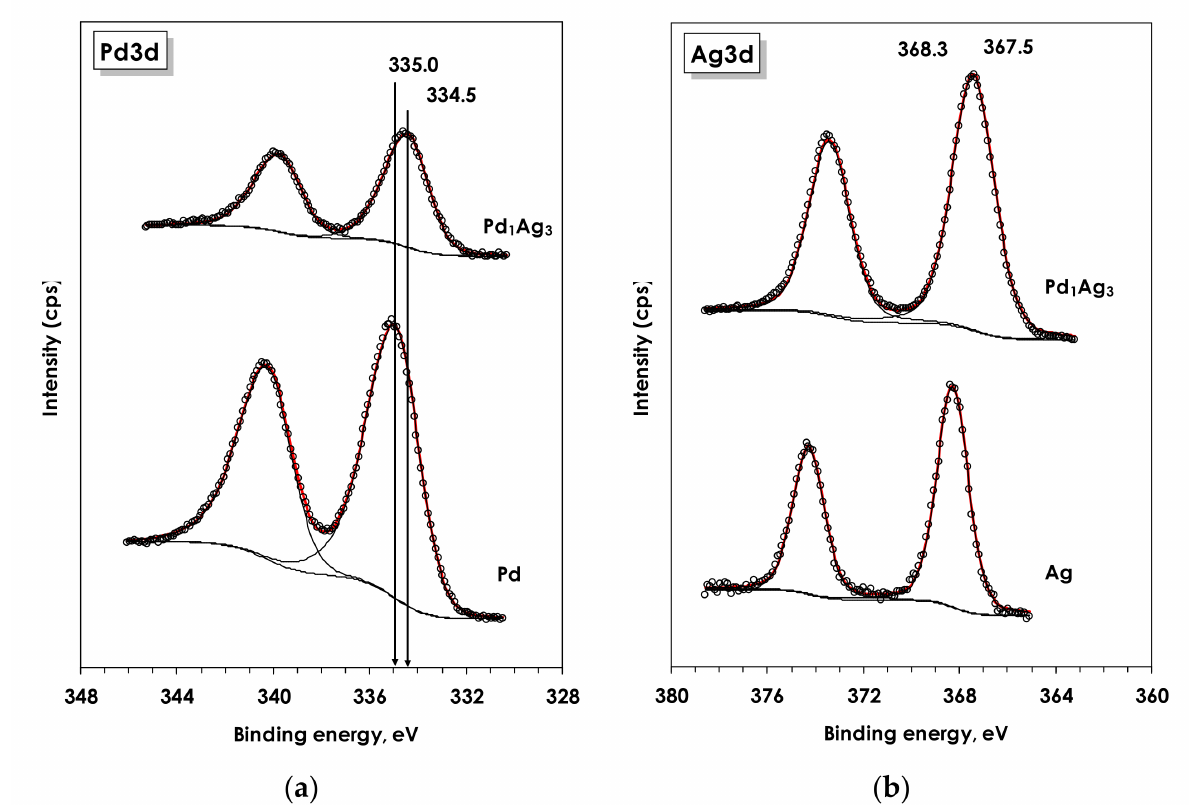
Figure 4. Pd3d ( a ) and Ag3d ( b ) spectra acquired for bimetallic Pd 1 Ag 3 /Al 2 O 3 and monometallic Pd/Al 2 O 3 and Ag/Al 2 O 3 .